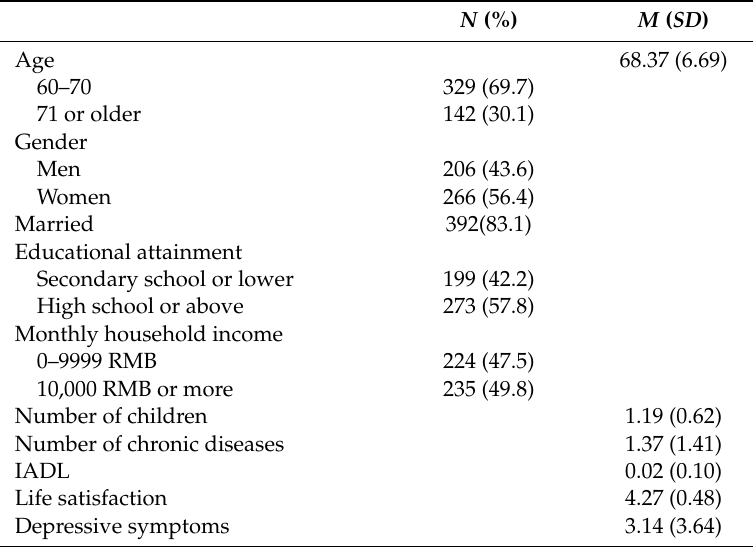
Table 1. Sample Characteristics ( N =